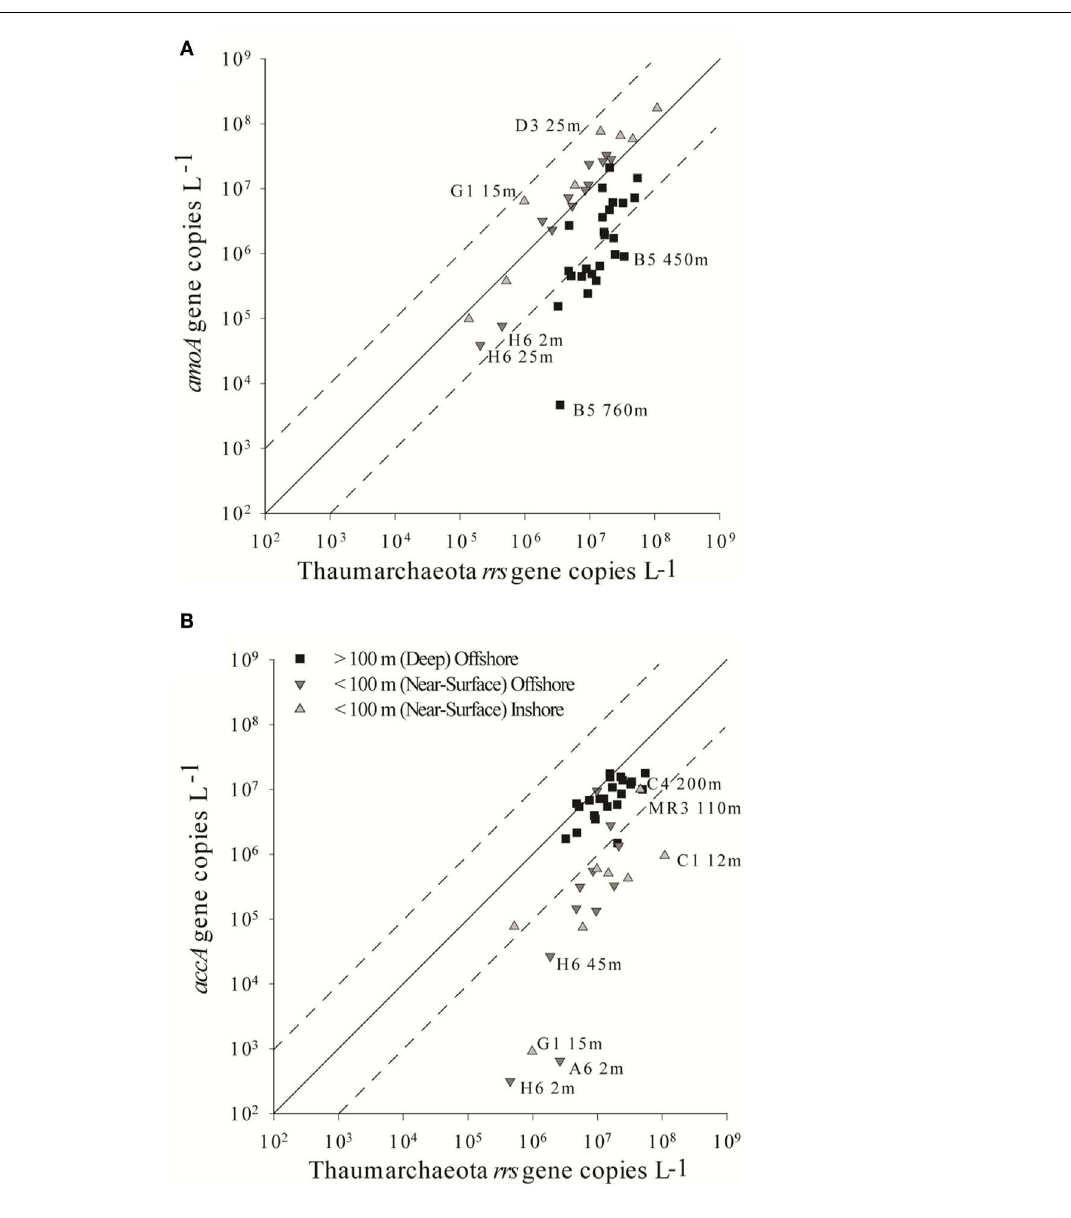
FIGUREA5 | Scatter plot ofArchaeal (A) amoA and (B) accA versus rrs gene abundance in samples from the northern Gulf of Mexico. Solid lines indicate the 1:1 ratios expected from the “ Ca. N. maritimus ” strain